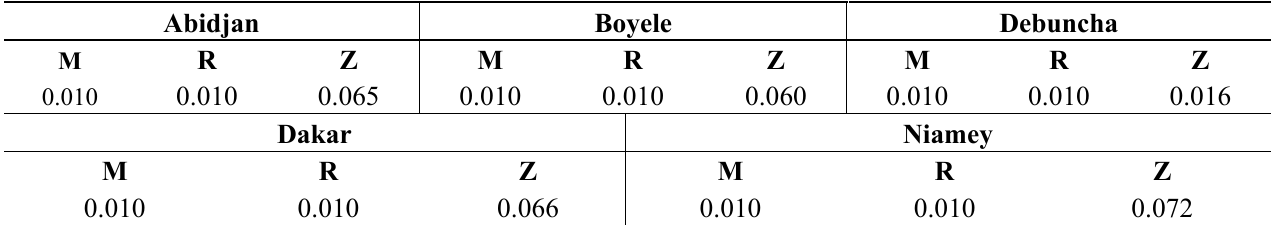
Table 8. RMSE between values measured by the disdrometer and those estimated by the PANN: Case of the stratiform rains.